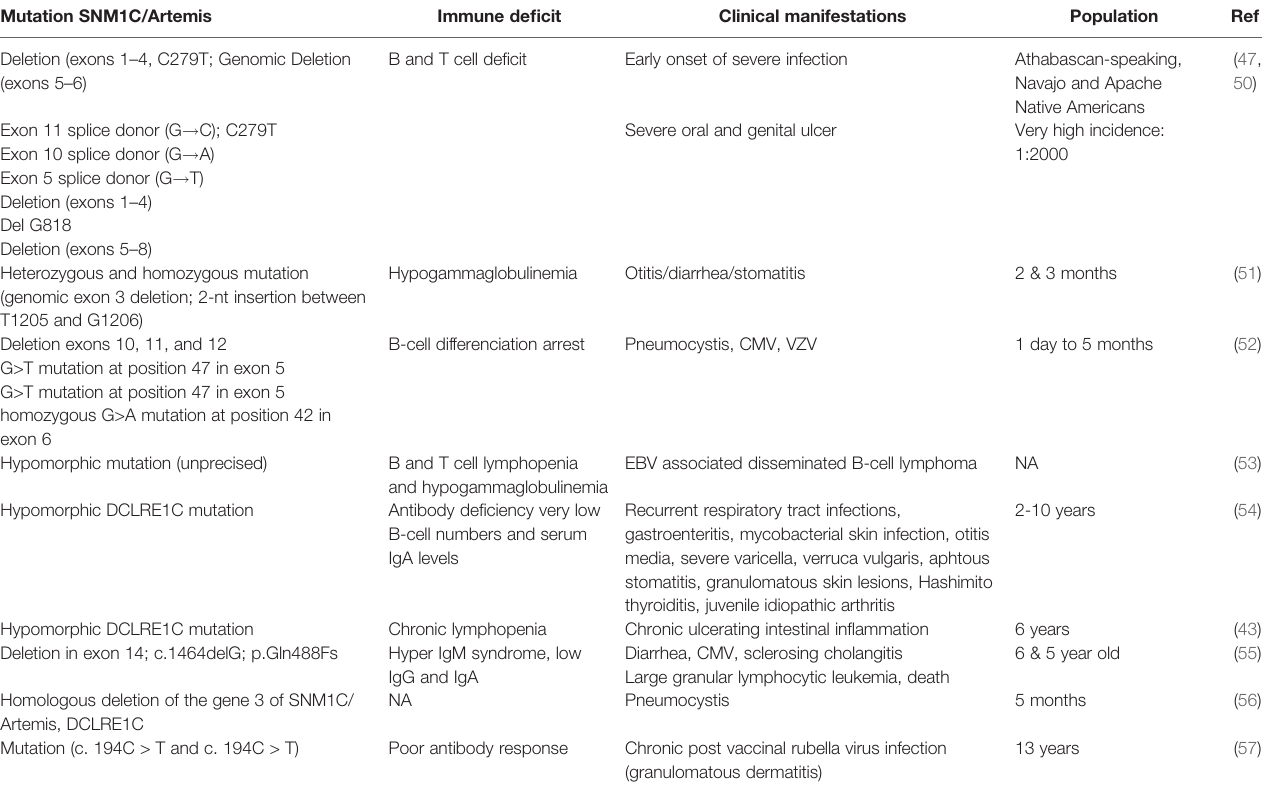
TABLE 2 | Clinical presentation of genetic SNM1C/Artemis mutation in human. Mutation